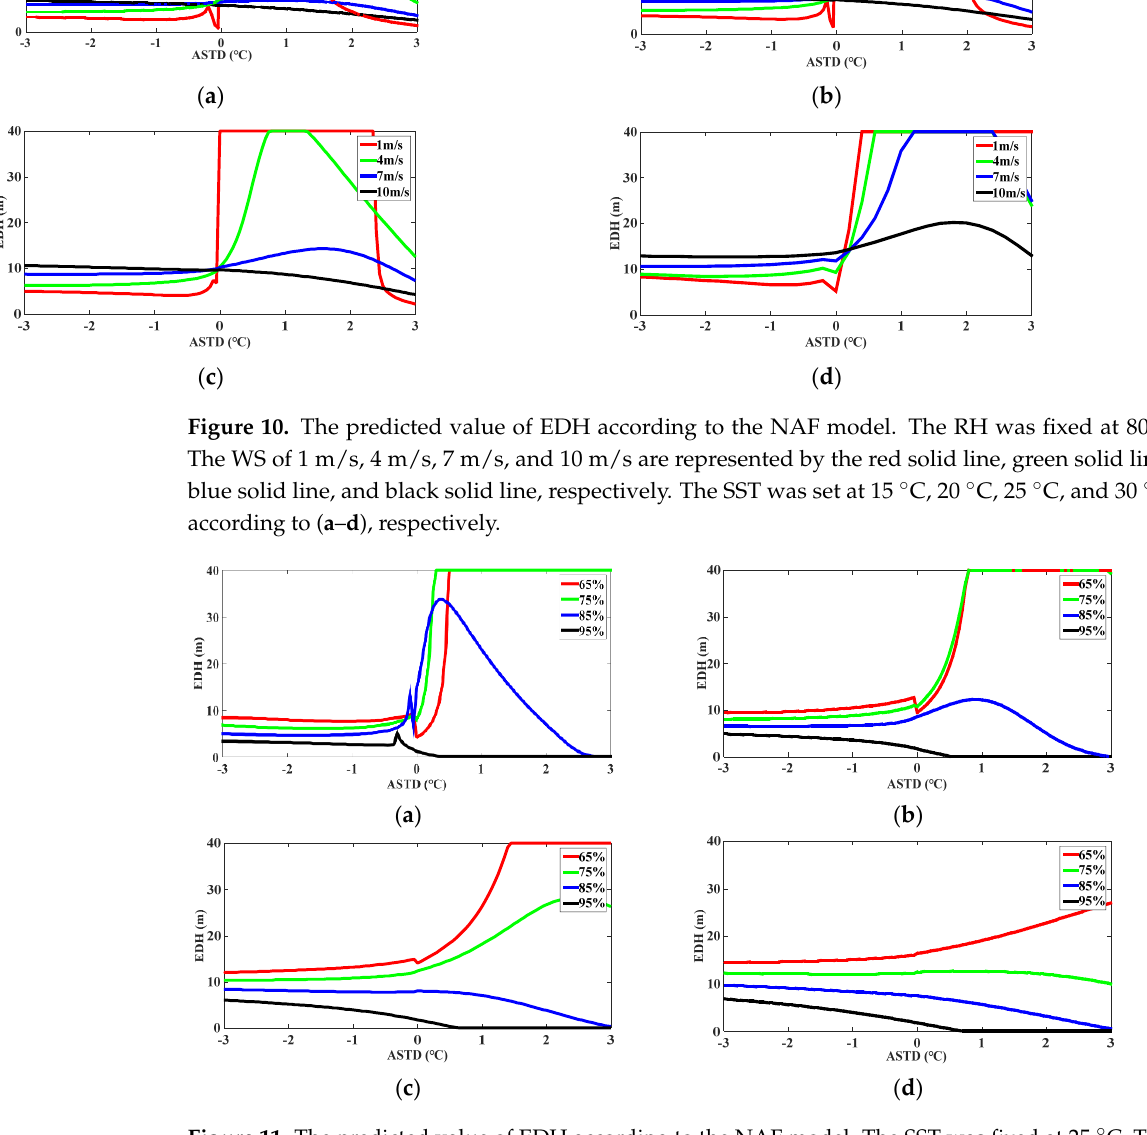
Figure 11. The predicted value of EDH according to the NAF model. The SST was fixed at 25 °C. The RH of 65%, 75%, 85%, and 95% are represented by the red solid line, green solid line, blue solid line, and black solid line, respectively. The WS was set to 1 m/s, 4 m/s, 7 m/s, and 10 m/s according to ( a – d ), respectively.